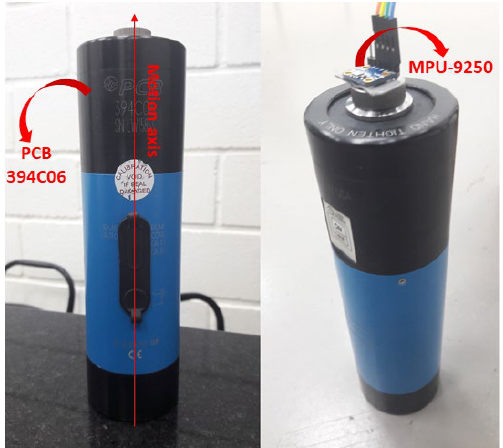
Figure 3. Testing setup (MPU-6050 attached to the